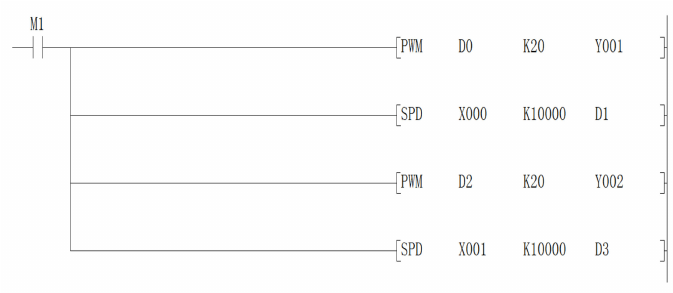
Figure 11. PLC program line diagram of speed control of the cutter.